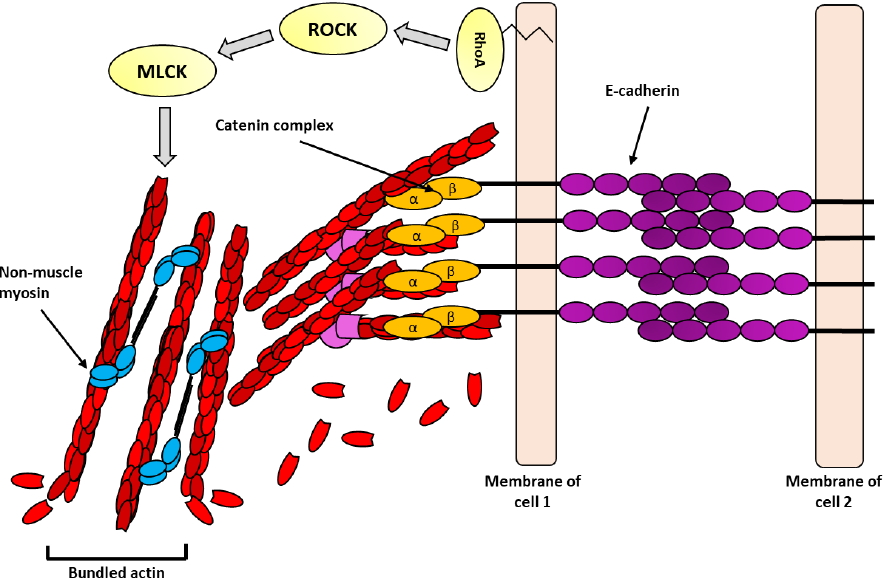
Figure 4. Hypothetical illustration of the actin cytoskeleton at adherens junctions under force: ( A ) E-cadherin (purple circles) forms strong homophilic interaction between adjacent cells. Adaptor proteins, such as, β - and α -catenin form cytosolic adhesion complex (orange circles) and link E-cadherin to the actin cytoskeleton (red units). In response to force, the RhoA pathway (yellow) is activated, which in turn activates the actomyosin pathway culminating in force generation by non-muscle myosin (blue ovals) and further reinforcement of the actin cytoskeleton.